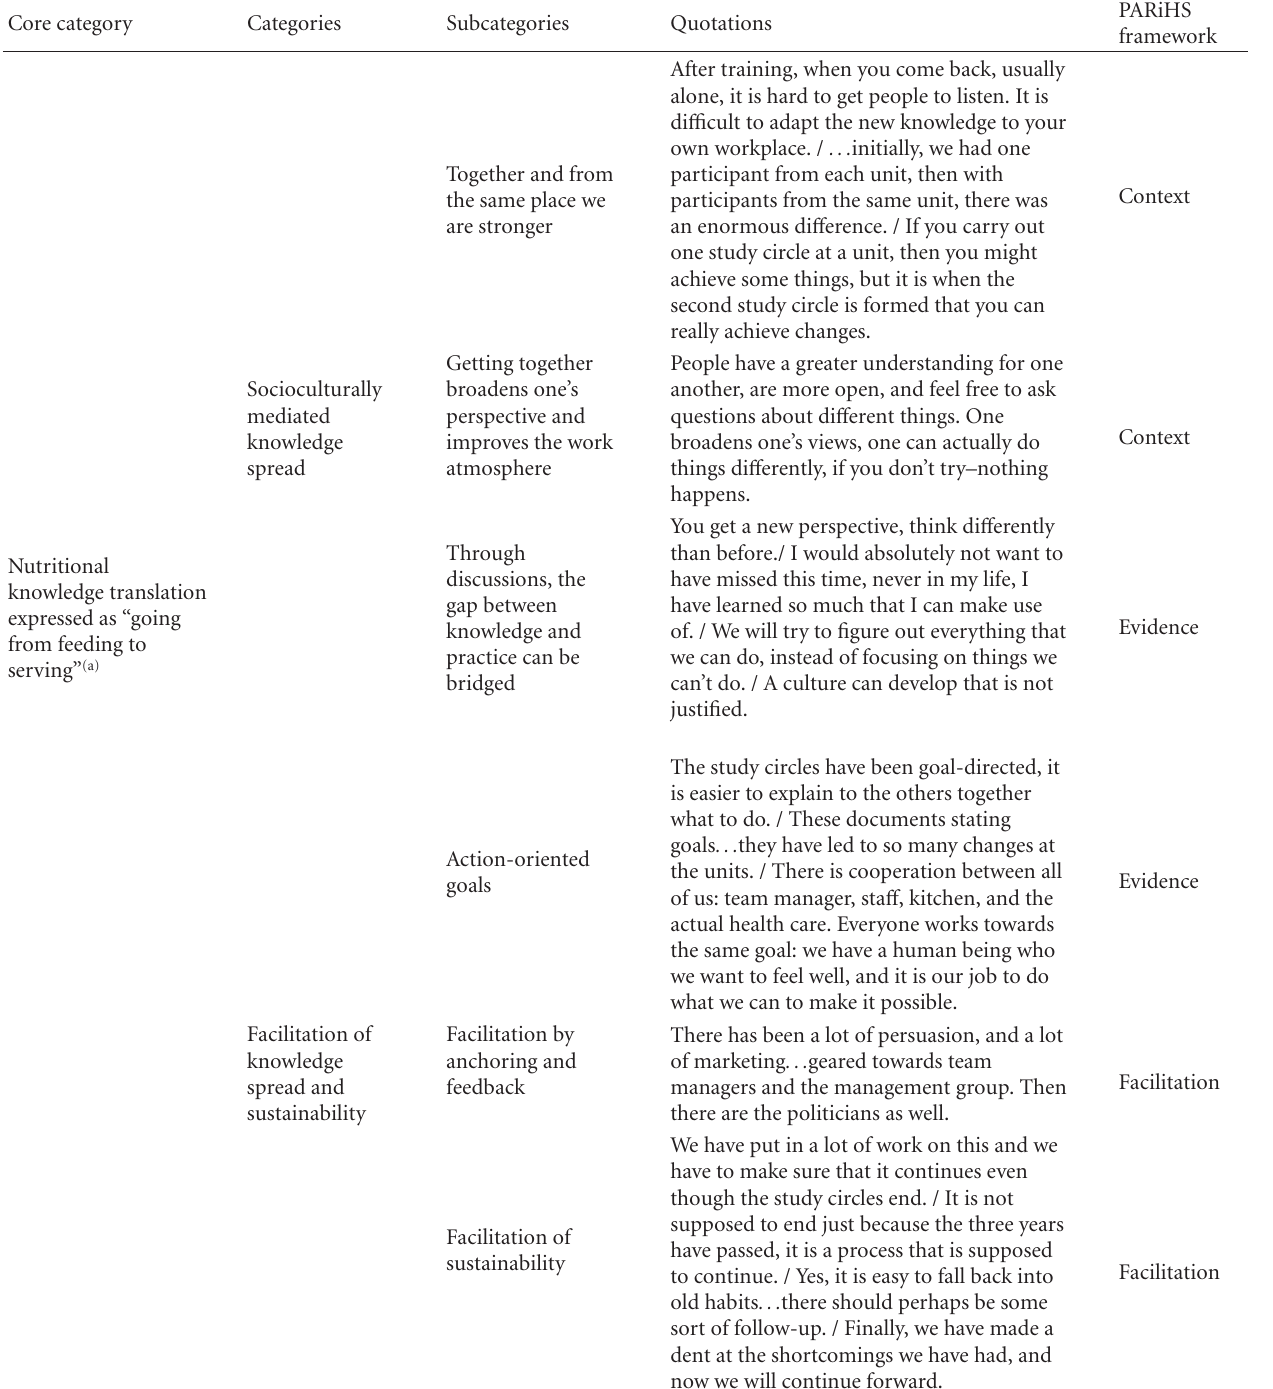
Table 6: Inductive results structured into core category, categories, subcategories, and quotations (di ff erent quotations are separated by a slash). The PARiHS (Promoting Action on Research Implementation in Health Sciences) framework deduced to the inductive